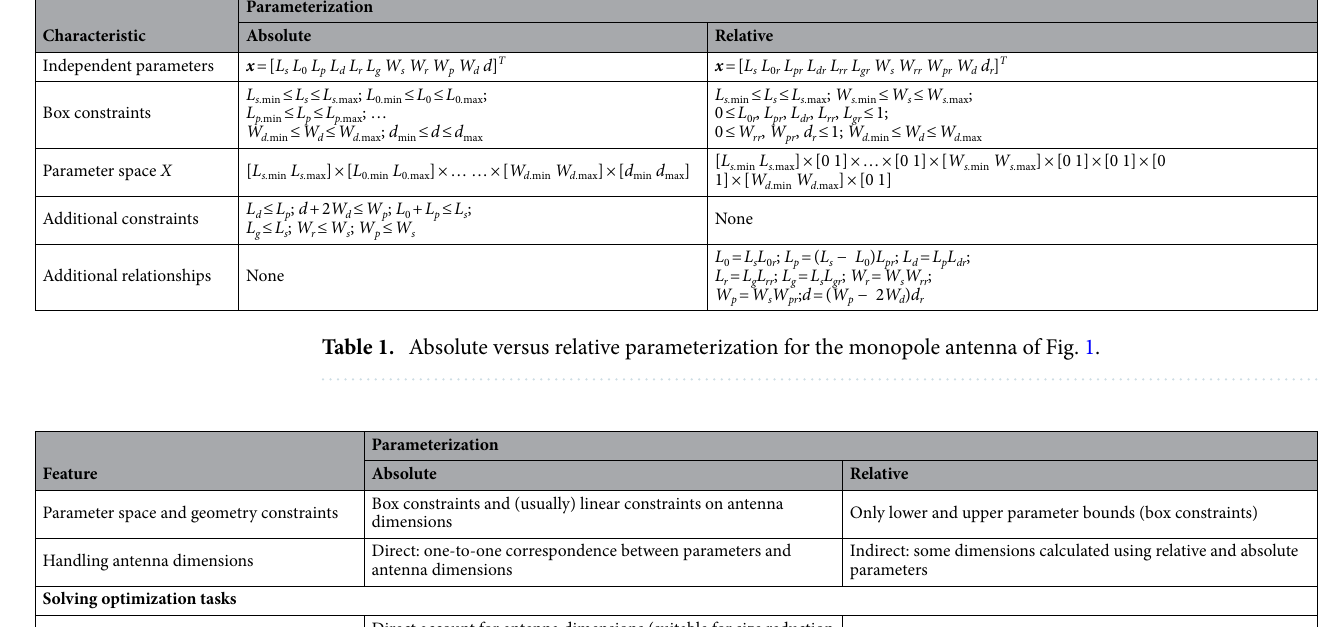
Only lower and upper parameter bounds (box